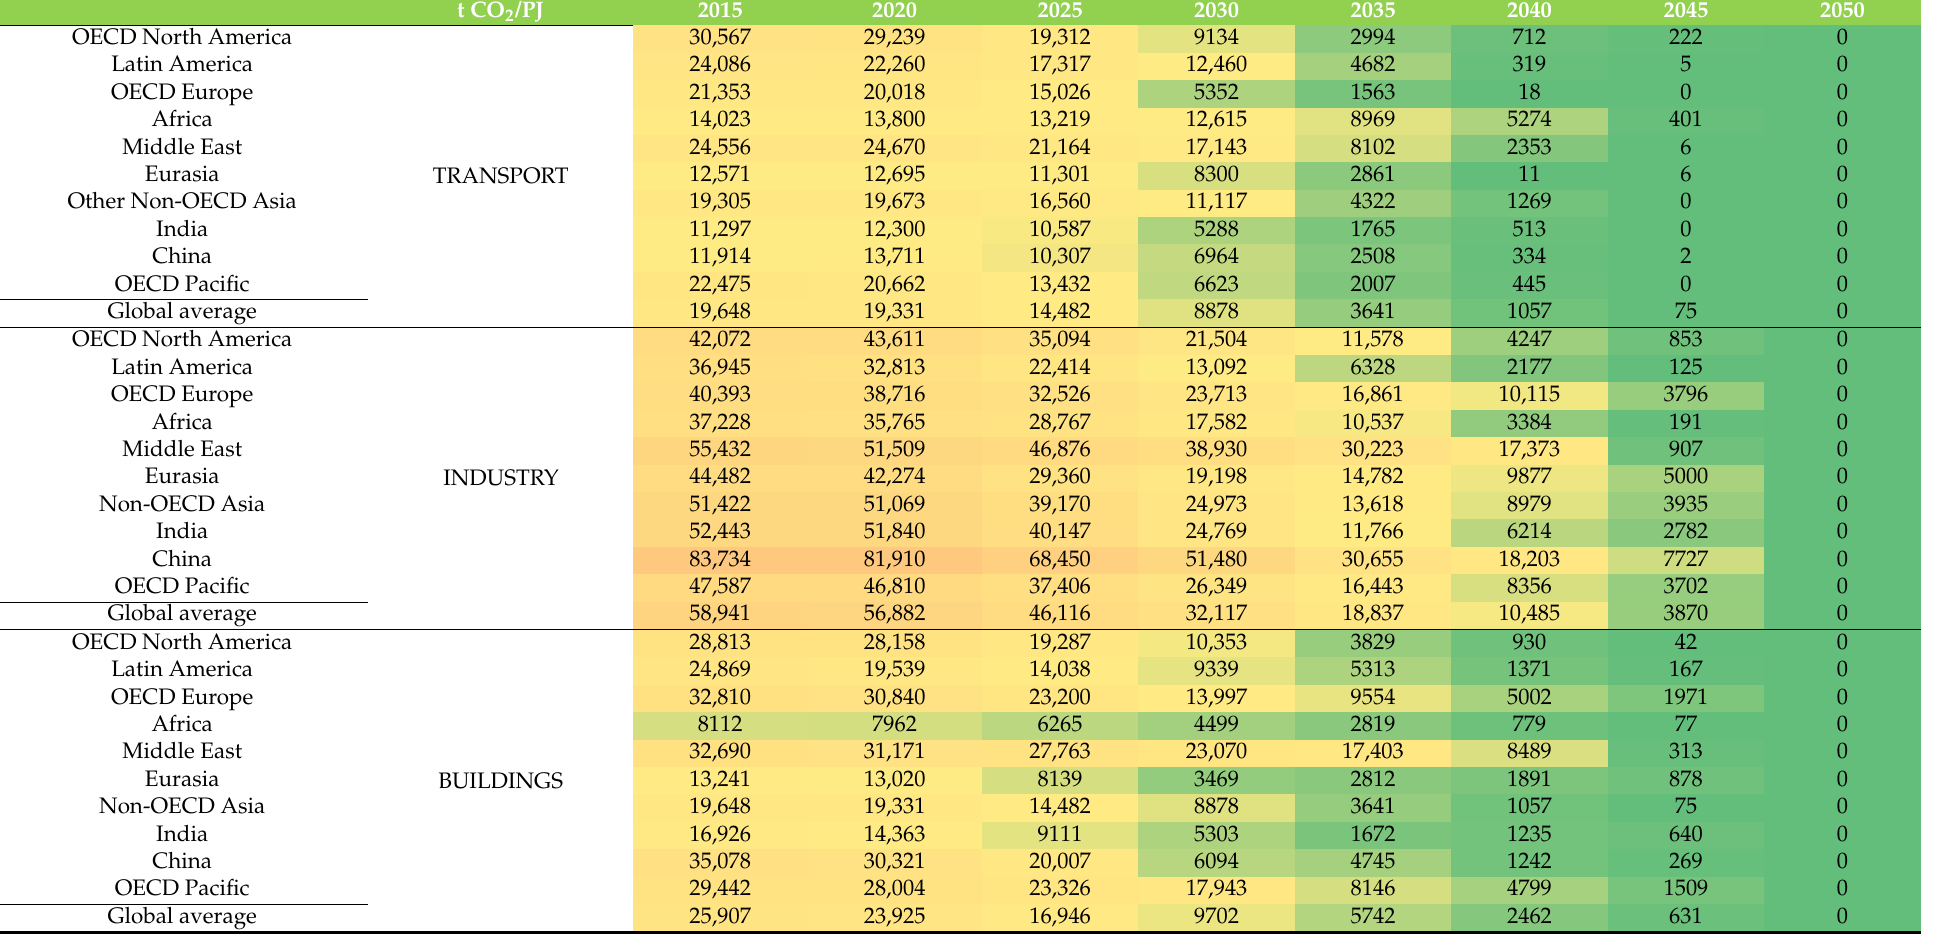
Table 3. Carbon intensity by sector under the 1.5 ◦ C Scenario. Carbon intensities for the industry, building, and transport sectors exclude the electricity consumed in these sectors. The prerequisites for reduced carbon intensity in the industry sector include infrastructural changes, such as renewables-based process heat generation technologies and co-generation. For the transport sector, infrastructural changes are required, such as charging networks for electric vehicles and the expansion of electricity-based public transport. The colour indicates the different carbon intensities by sector and region where red is high, yellow more average values and green low carbon